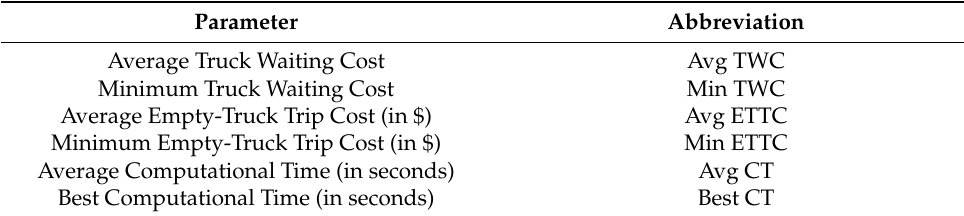
Table 10. Performance comparison between DQN and TS.